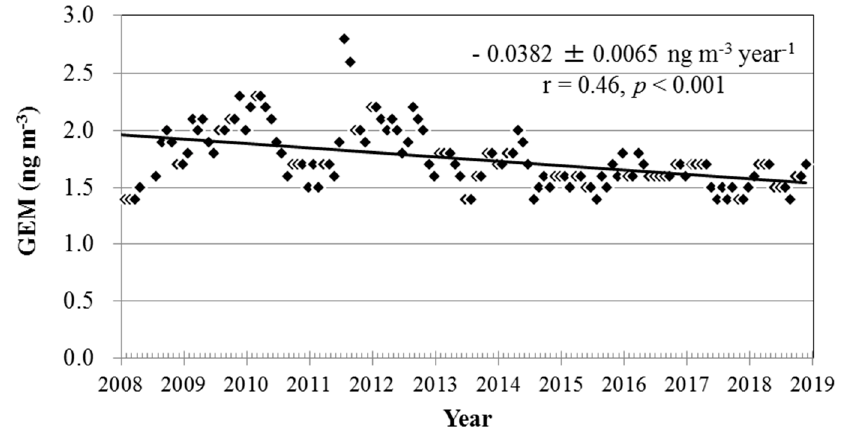
Figure 10. Long-term variations in the monthly mean GEM concentrations. The slope of the least-square regression represents its annual trend.